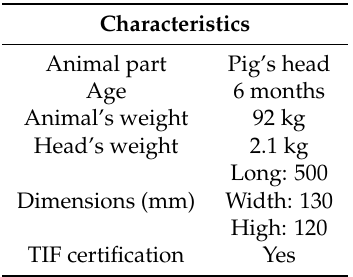
Table 2. Dimensions, weights, and sample’s age.